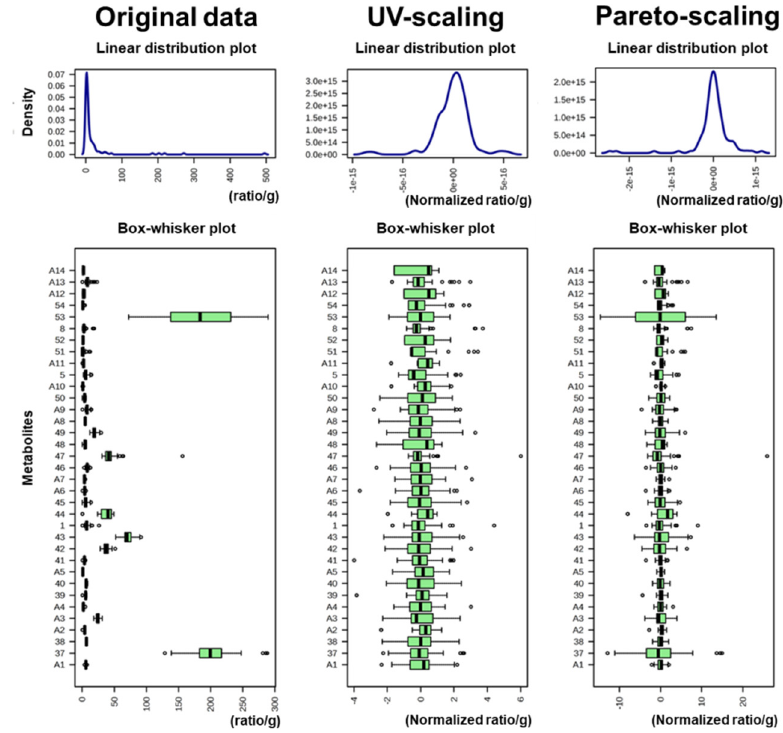
Figure 4. Normalisation results of non-targeted metabolite profiling data. Ratios were calculated by the peak area of each metabolite based on those of the internal standard (ribitol).